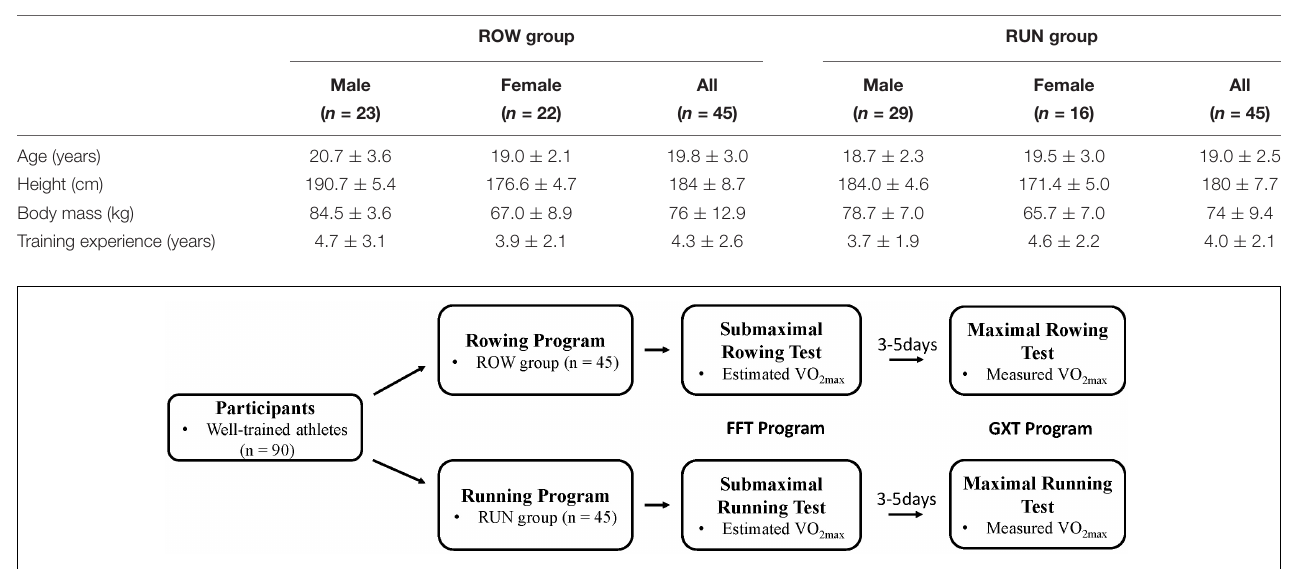
TABLE 1 | Descriptive characteristics of the participants.